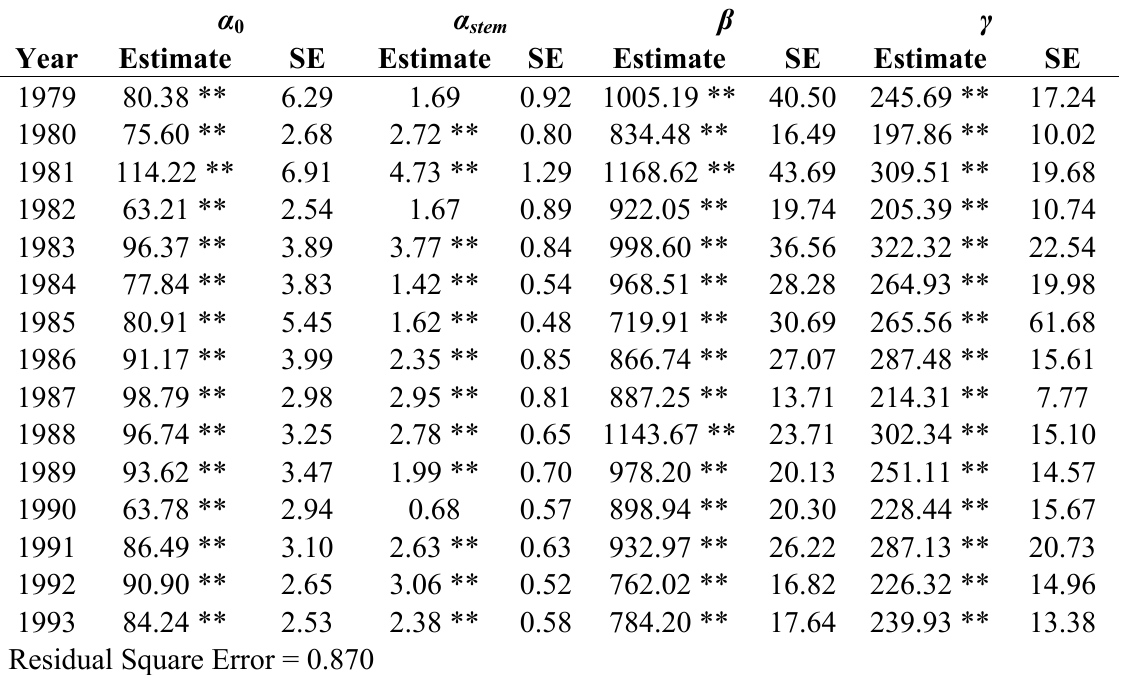
Table 3. Least squares estimated parameters for the logistic model describing average potato tuber length as a function of accumulated growing degree days and stem number per plant.